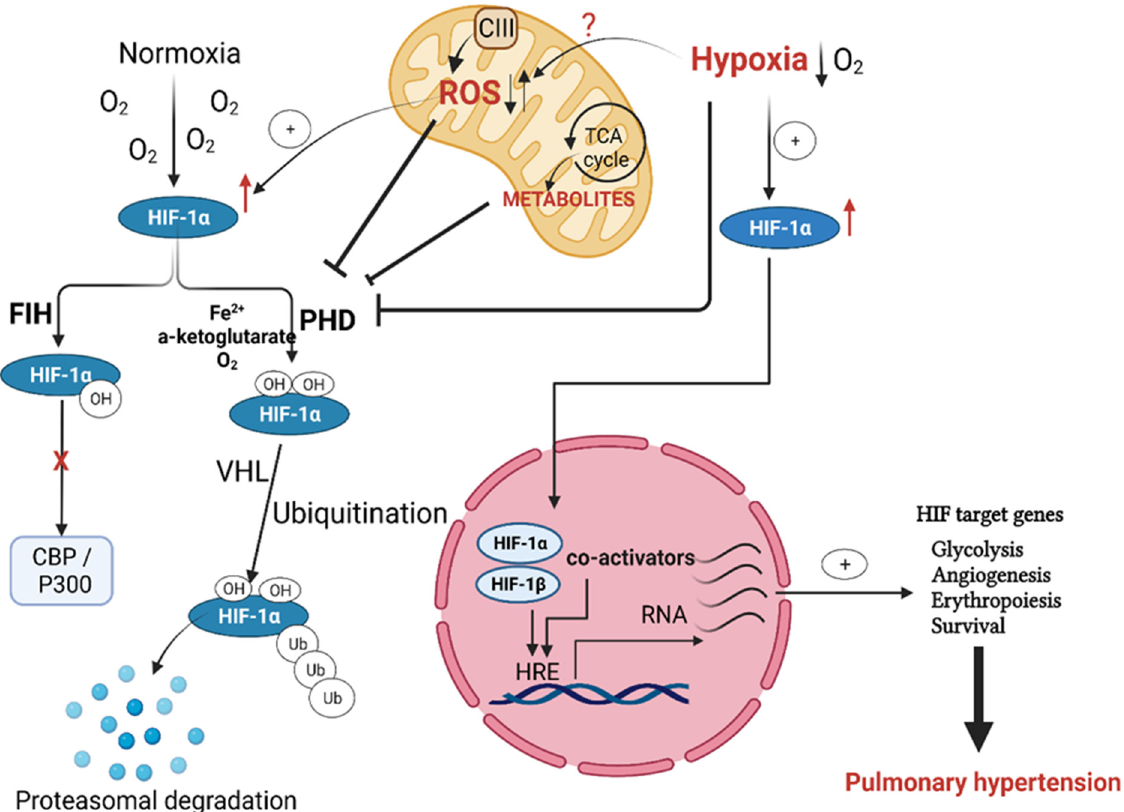
Figure 1. Regulation of hypoxia-inducible factor (HIF) activation in pulmonary hypertension. Both prolyl hydroxylases (PHD) and von Hipple–Lindau (VHL) hydroxylate HIF1 α under normoxia, with subsequent targeting for proteasomal degradation. Factor-inhibiting HIF (FIH) controls HIF transactivation by impeding cofactor binding. Hypoxia, as well as mitochondria-produced ROS and metabolites, prevents HIF1 hydroxylation by PHD and subsequently allows its stabilization and nuclear translocation to form the active HIF transcription complex, which binds to its specific hypoxia response elements (HREs). The binding of this transcriptional complex to HREs activates HIF target genes essential to pulmonary hypertension initiation and progression.